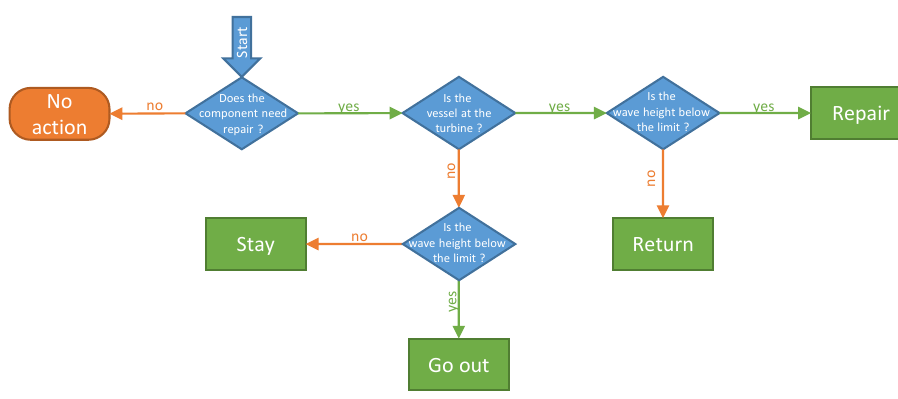
Figure 3. The decision tree for the original (go-right-away) policy. This assessment is conducted for each state and influences the transition probabilities in the MDP, by choosing an action for each state. An example of how the policy is applied can be seen in Figure 4.